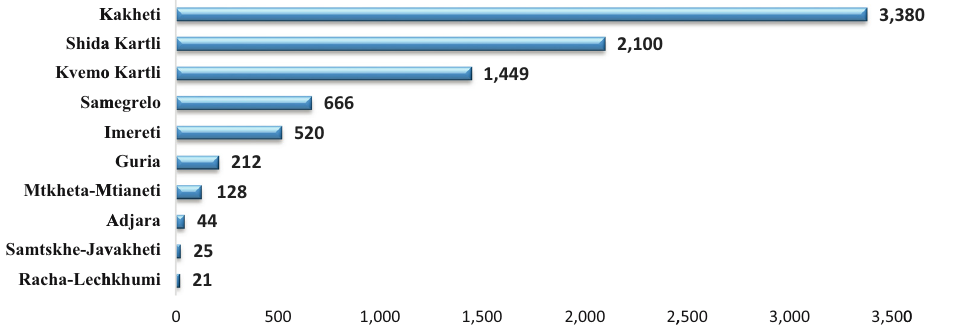
Figure 2: Planted area ( ha ) by regions in 2015 – 2019. Source: NNLE Rural Development